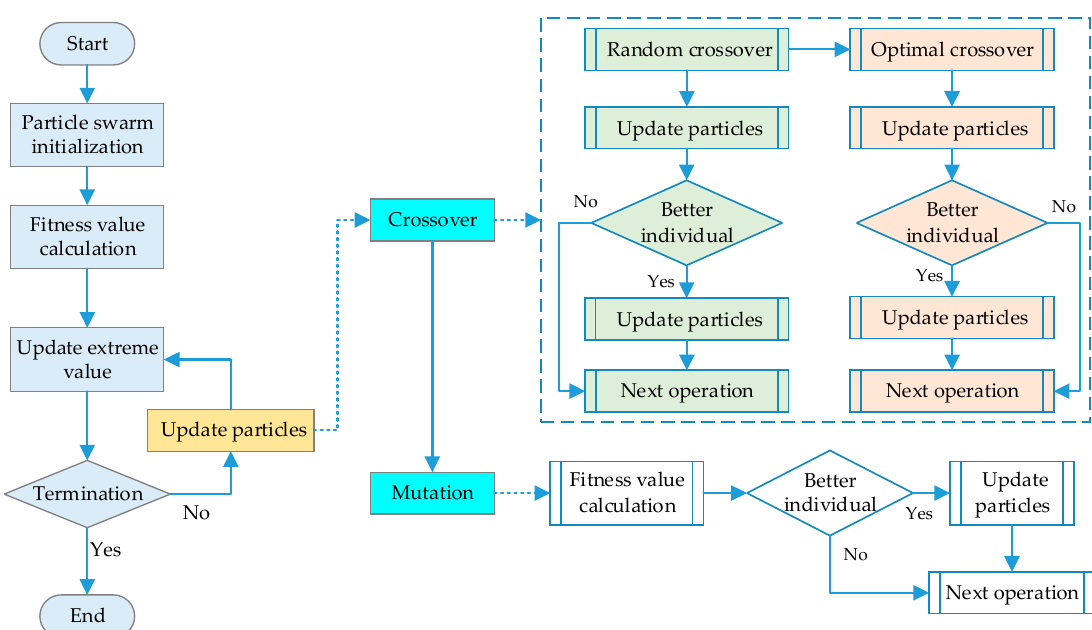
Figure 6. The process framework of the improved hybrid particle swarm optimization (HPSO) algorithm for process planning.